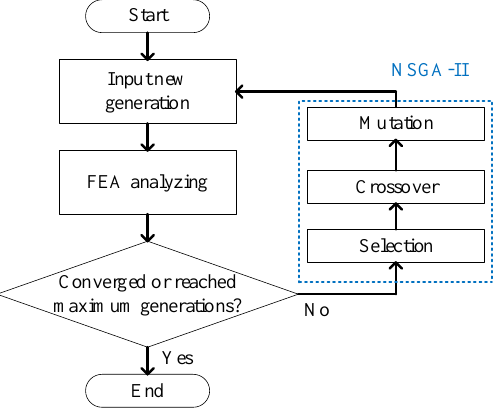
Figure 8. The optimization flowchart using FEA and NSGA-II.